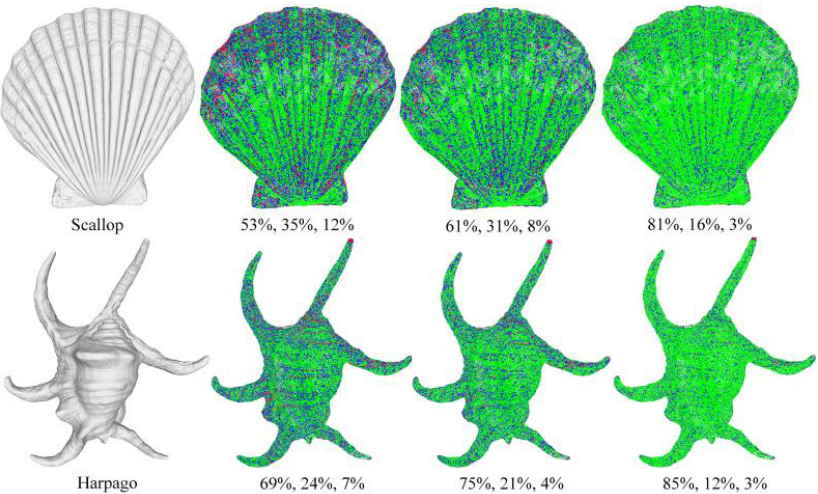
Figure 2. The normal estimation error. Green denotes points with an estimated normal that deviates by less than 5 ◦ from the ground-truth normal; blue encodes angular deviations between 5 ◦ and 10 ◦ ; and red marks errors more than 10 ◦ . From left to right are the model, PCA, WPCA, and NERL methods, and the percentages of green, blue, and red points are counted under each result. The normals of the points in the smooth regions are reliably computed through NERL, whereas those of the points near the edges still fail to preserve sharp features. Therefore, it is indispensable to distinguish the feature points further. In order to make feature detection more applicable, we divided it into two cases according to the noise scale to deal with separately. Under the condition of small-scale noise, for each point p i , the eigenvalues of its covariance matrix computed by PCA and NERL methods can be obtained by singular value decomposition, and the feature coefficients w i 1 , w i 2 are calculated by their three eigenvalues, respectively, corresponding to ( λ 0 , λ 1 , λ 2 ) , ( λ (cid:48) 0 , λ (cid:48) 1 , λ (cid:48) 2 ) with ascending